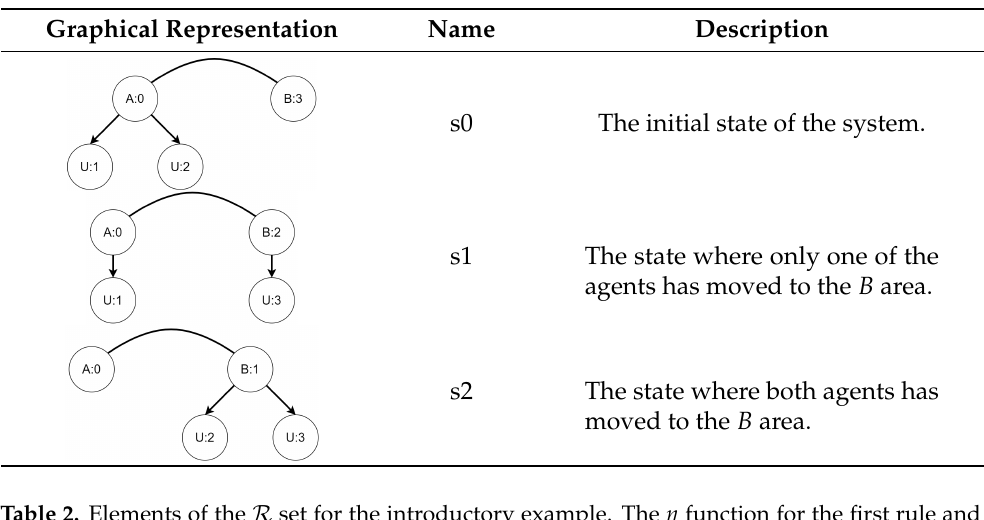
Table 1. Elements of the